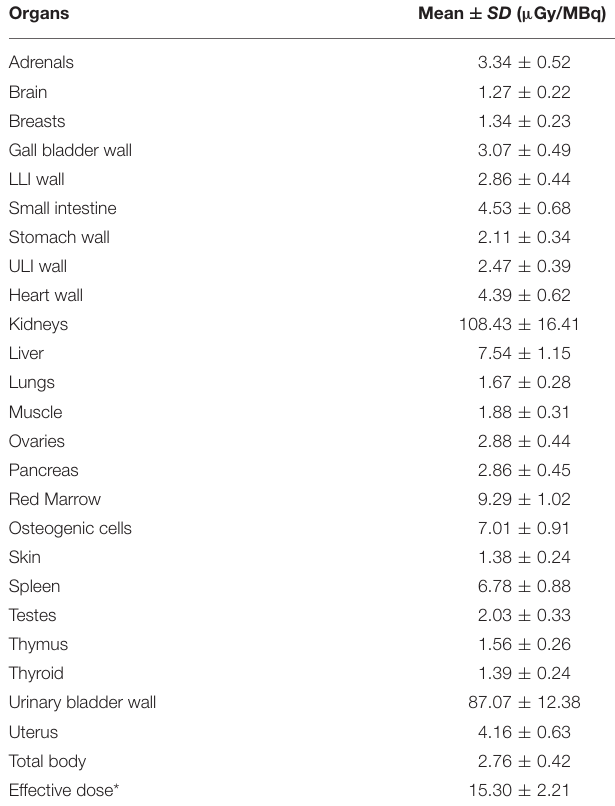
TABLE 3 | Estimated human absorbed doses of 64 Cu-BaBaSar-RGD 2 to normal organs using biodistribution data from macaque monkey.